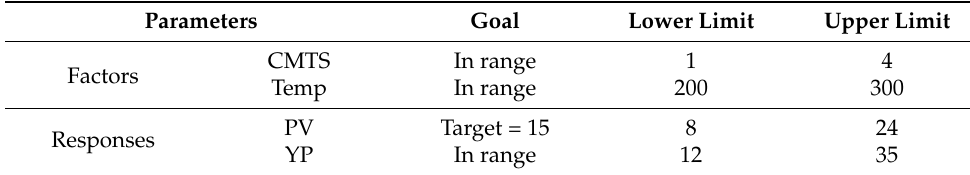
Table 7. Rheology optimization input